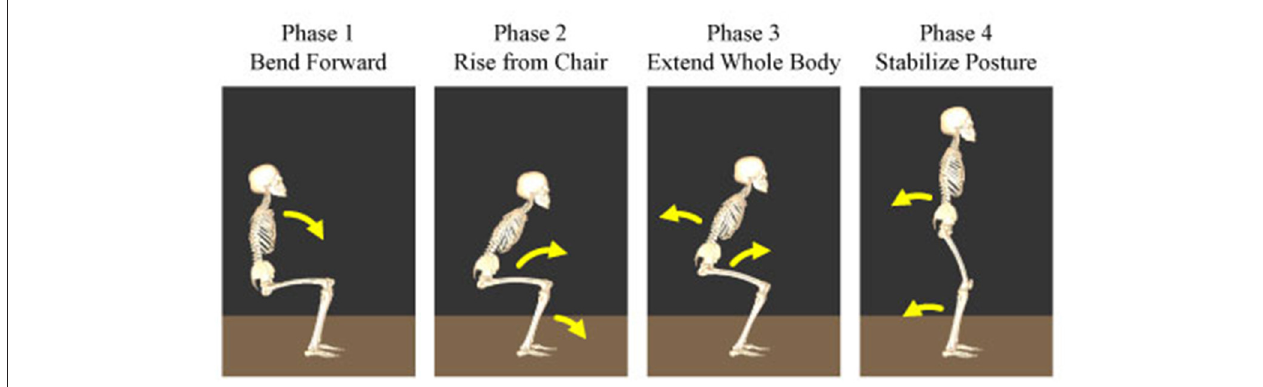
FIGURE 2 | Four phases of the human sit-to-stand motion. In phase 1, humans flex their upper body to generate momentum and initiate the sit-to-stand motion. In phase 2, they raise their hip from the chair and transfer momentum. In phase 3, humans extend their whole body upward. In phase 4, they move their body backward to stabilize their posture.